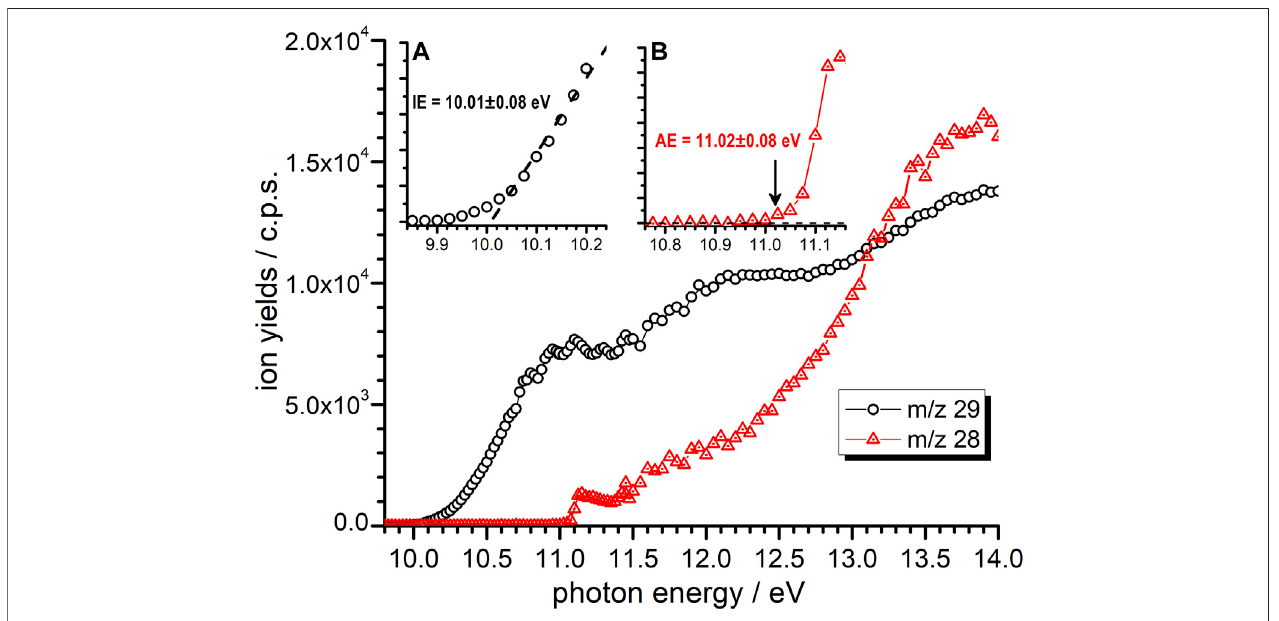
(cid:129) radical cations ( m/z 29)